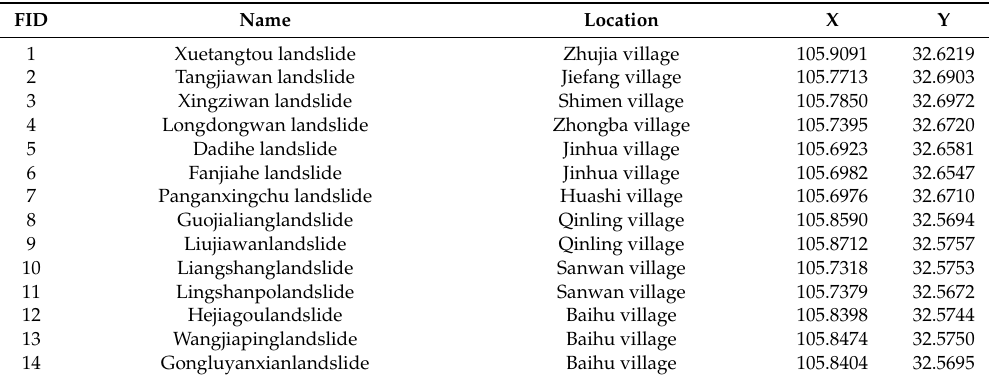
Table A1. Details of historical landslide catalog